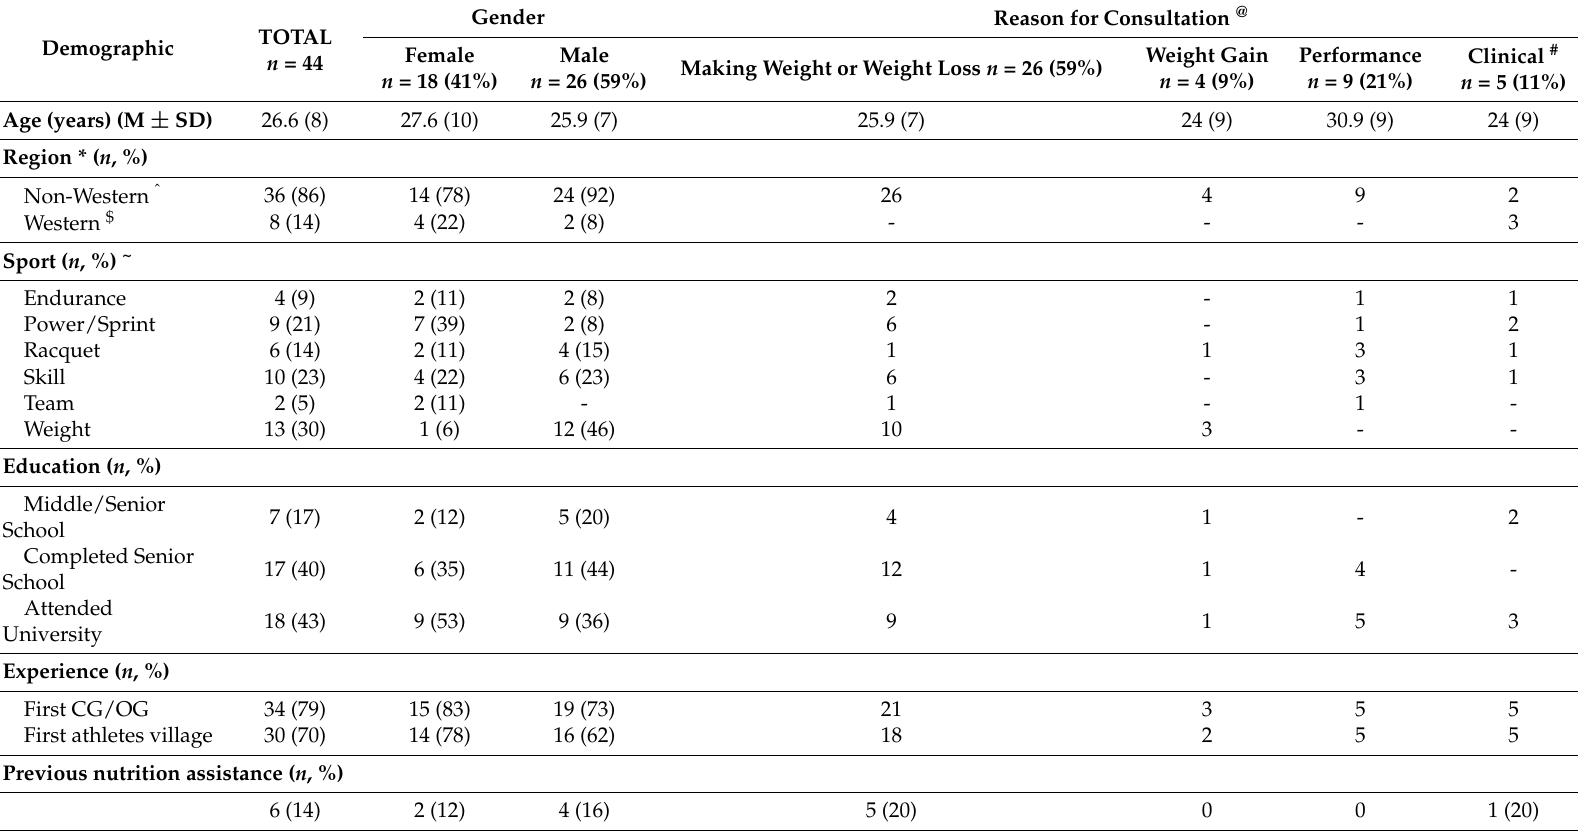
Table 1. Demographic information of all athletes who took part in a 24 h